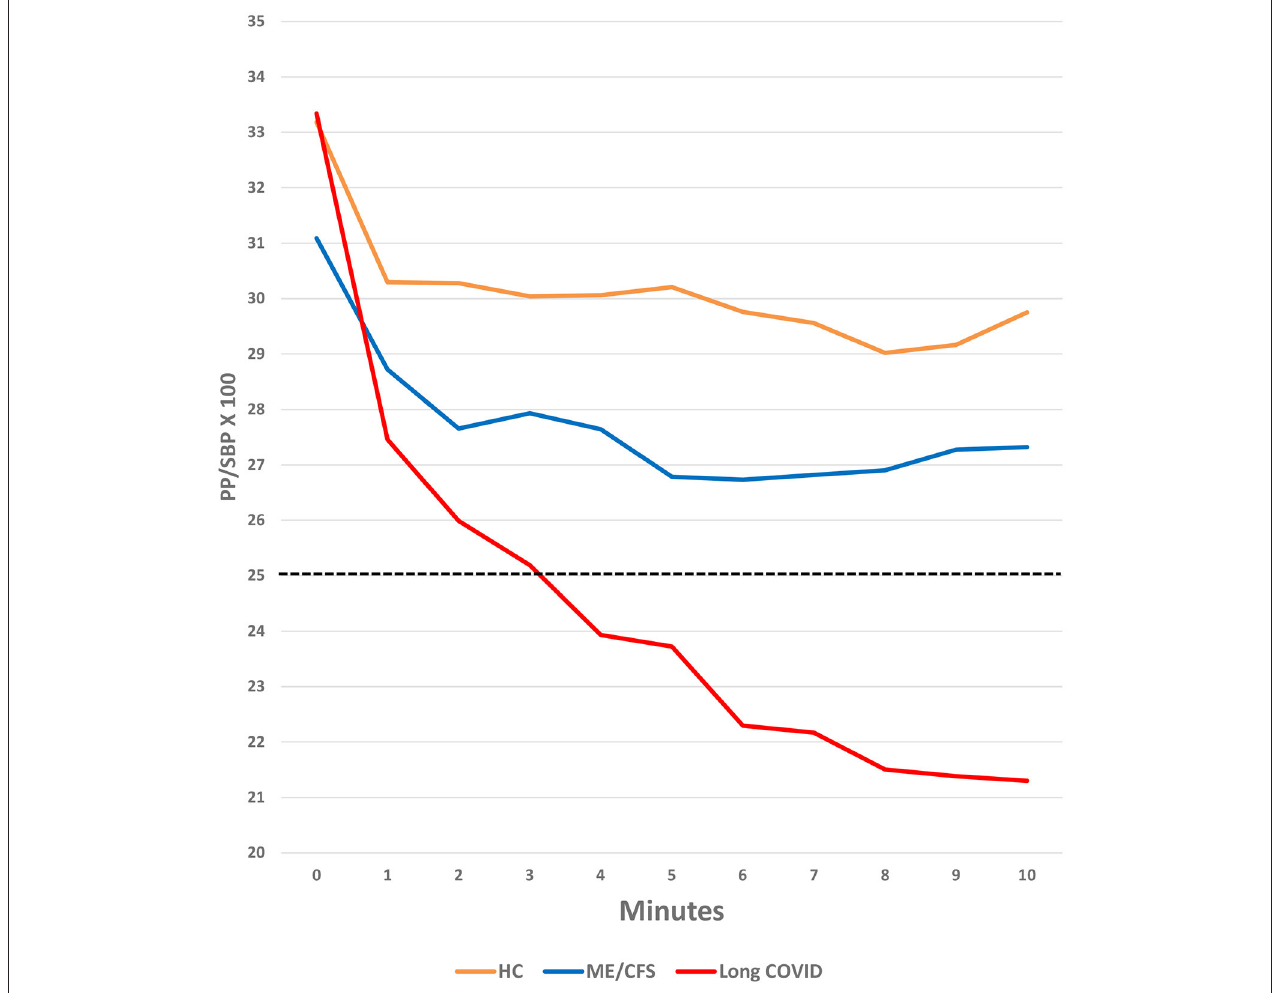
FIGURE 2 | Change in PP/SBP × 100 during the NASA Lean Test in Long COVID, ME/CFS and healthy control subjects.